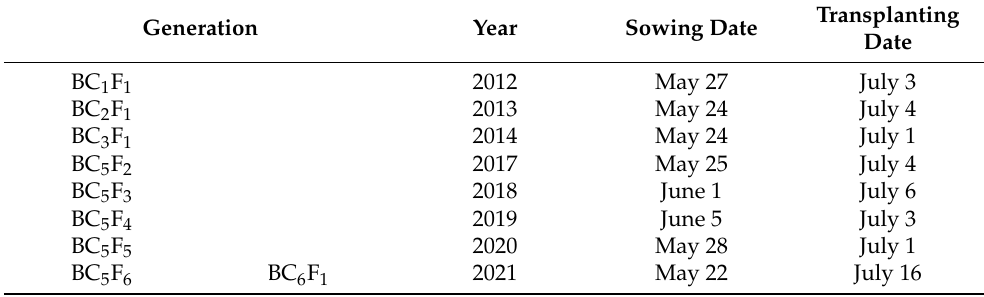
Table 7. Year of cultivation, sowing date and transplanting date of the materials in this study.